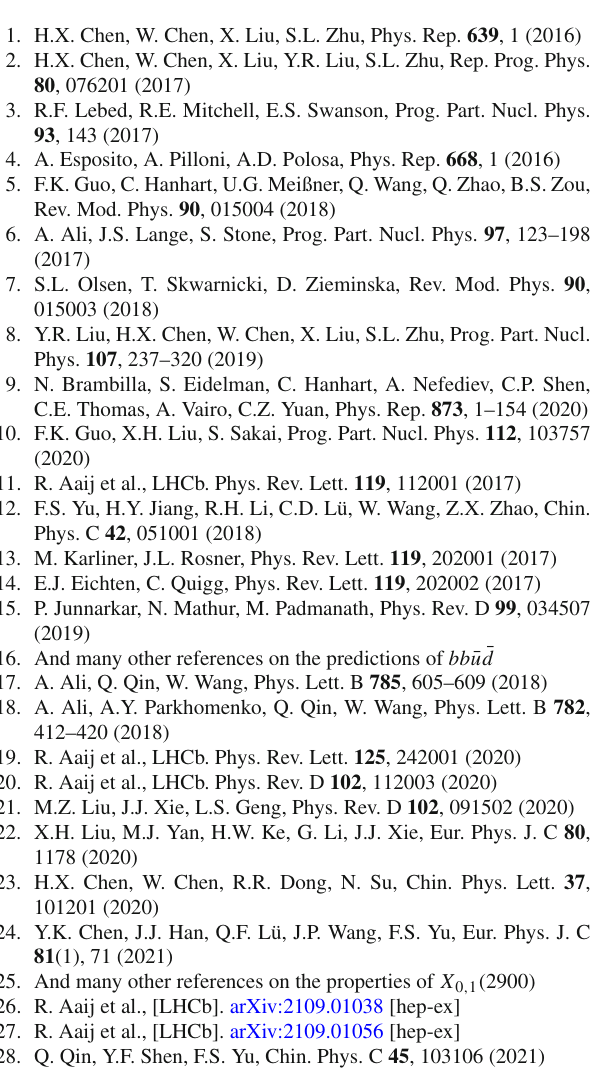
0.45 ps, smaller than those of charmed mesons from 0.41 ps to 1.04 ps, and much smaller than those of bottom hadrons are expected to be with 1.5 ps. So then the lifetime of T 0 cs smaller than charmed baryons with even one more spec- tator quark. Such short lifetime would make it difficult to decays from the pri- distinguish the secondary vertex of T 0 cs mary vertex of prompt productions, so that difficult to lower down the backgrounds. Beside, the combined backgrounds of K − K − π + π + are too large at the proton-proton